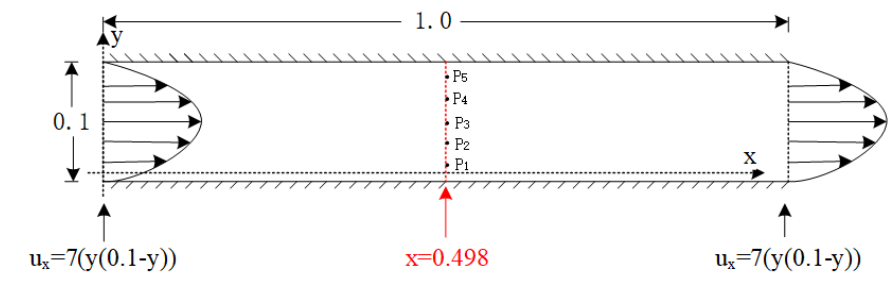
Figure 3. Poiseuille flow in a planar channel and the velocity component u y = u z = 0. We perform measurements on the line x = 0.498 or at the grid points P 1 = ( 0.498,0.01 ) , P 2 = ( 0.498,0.03 ) , P 3 = ( 0.498,0.05 ) , P 4 = ( 0.498,0.07 ) and P 5 = ( 0.498,0.09 ) .